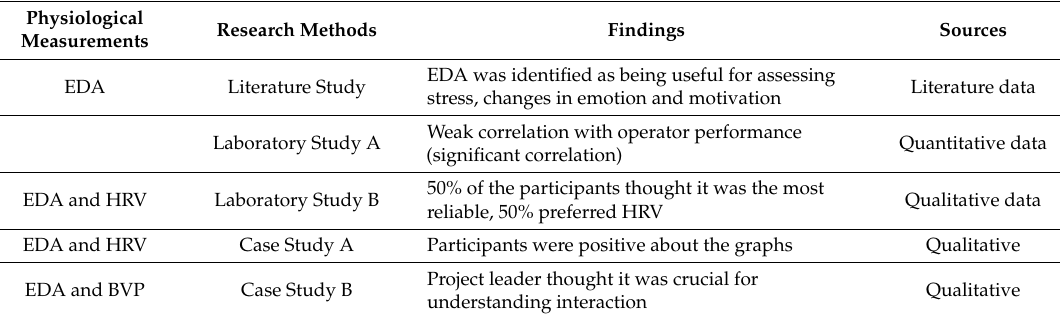
Table 4. Summarized